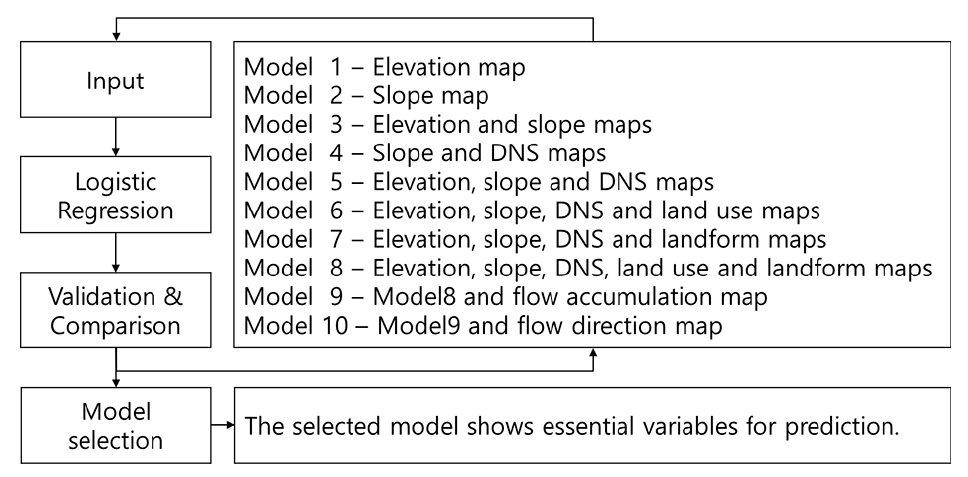
Figure 5. Algorithmic flow diagram of logistic regression.